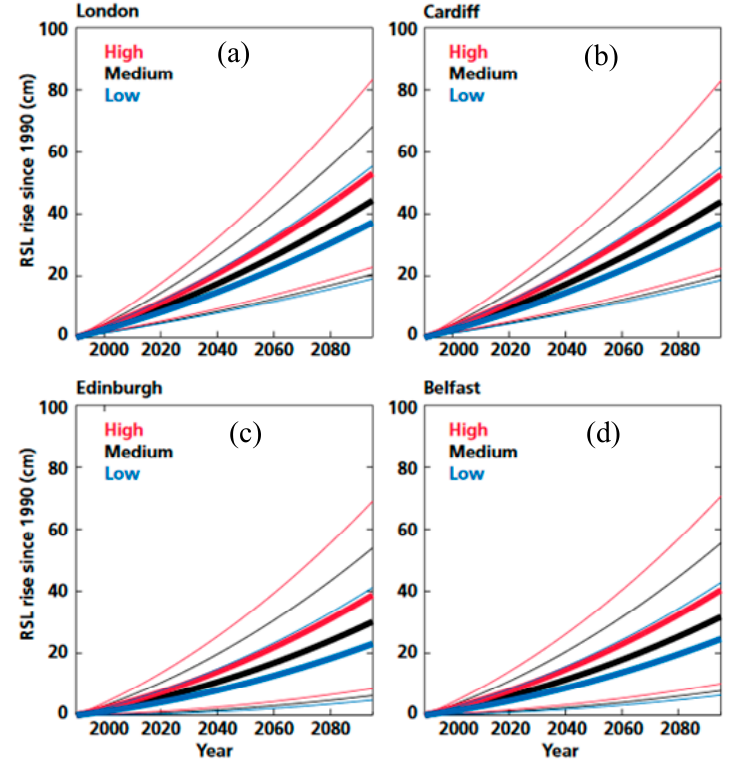
Figure 2. The Relative Sea Level Rise (RSLR) over the 21st century based on three emission scenarios with central estimate values (thick lines) and 5th and 95th percentile limits of the range of uncertainty (thin line) at four sample locations around the UK: London ( a ), Cardiff ( b ), Edinburgh ( c ), Belfast ( d ). The ‘London’ site ( a ) is the nearest from Deben Estuary [14]. Figures are adapted with permission from UK Climate Projection 2009 under Open Government License v3.0.